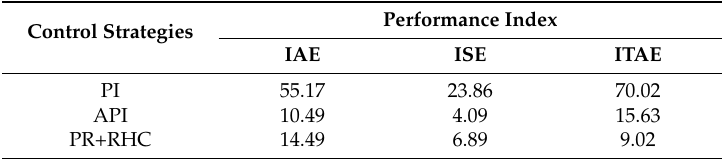
Table 9. Performance evaluation of the designed control strategies for I d .